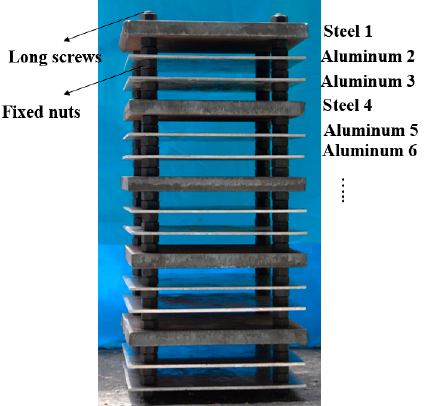
Figure 5. Photo of a marked multilayer target.